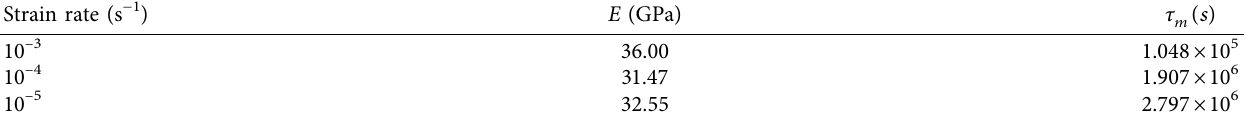
Table 3: Concrete mechanical parameters under uniaxial loading obtained by curve